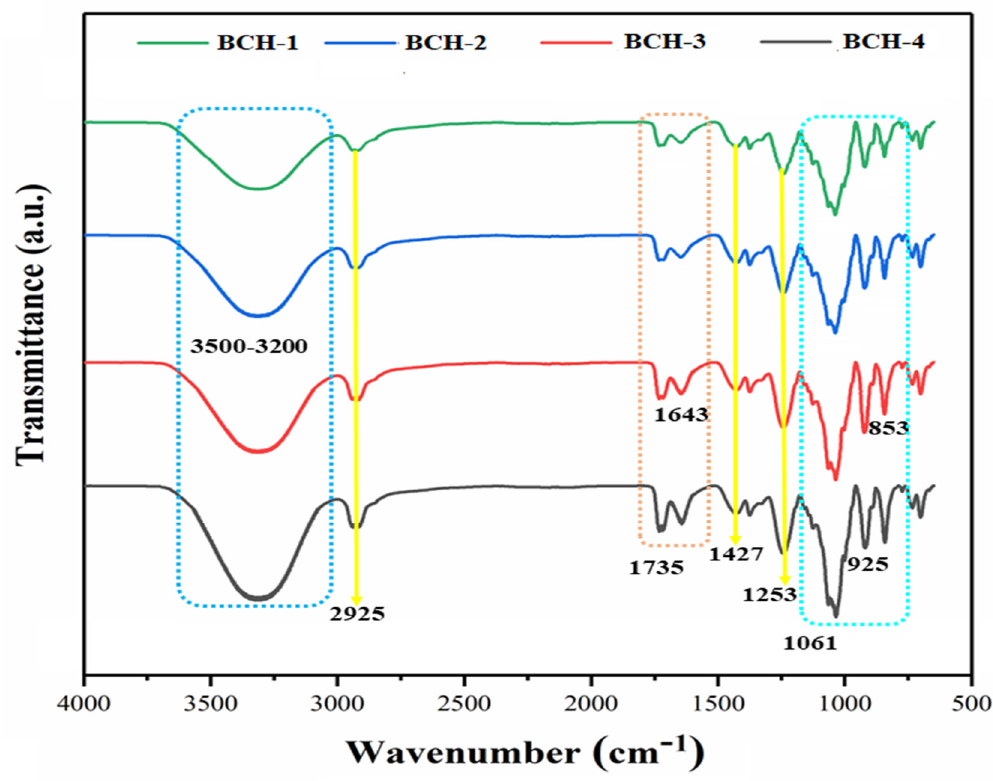
Figure 2. FT-IR spectrum of all samples of biocomposite hydrogel with different functional groups exhibiting successful cross-linking.